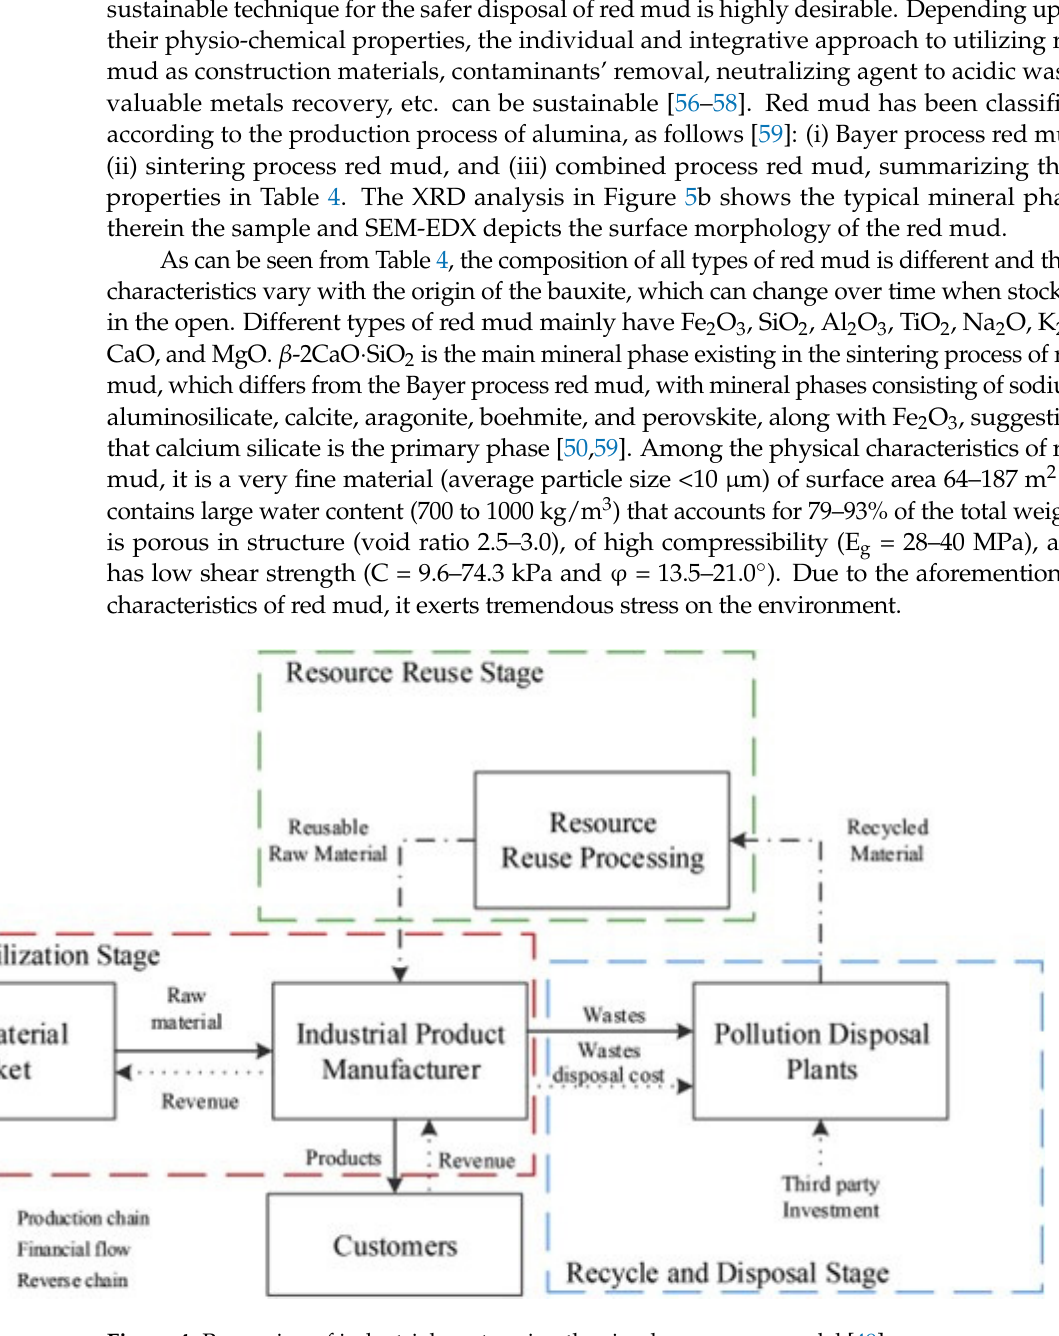
Figure 4. Processing of industrial waste using the circular economy model [49].